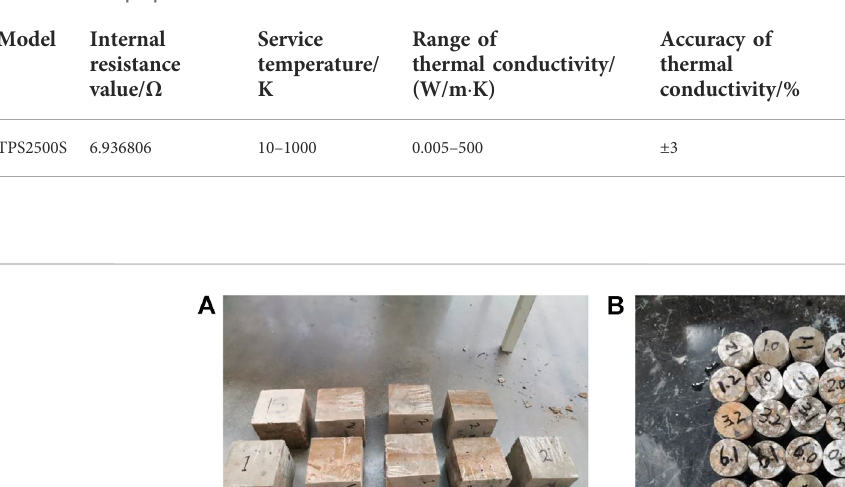
TABLE 16 Main properties of Hot Disk TPS2500S.